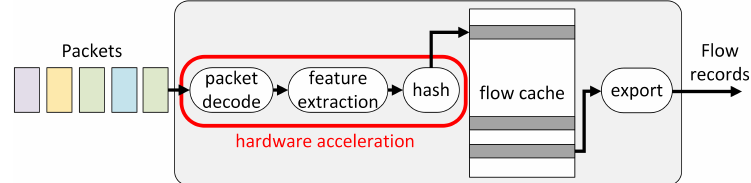
Figure 1. Block diagram of hardware-accelerated network